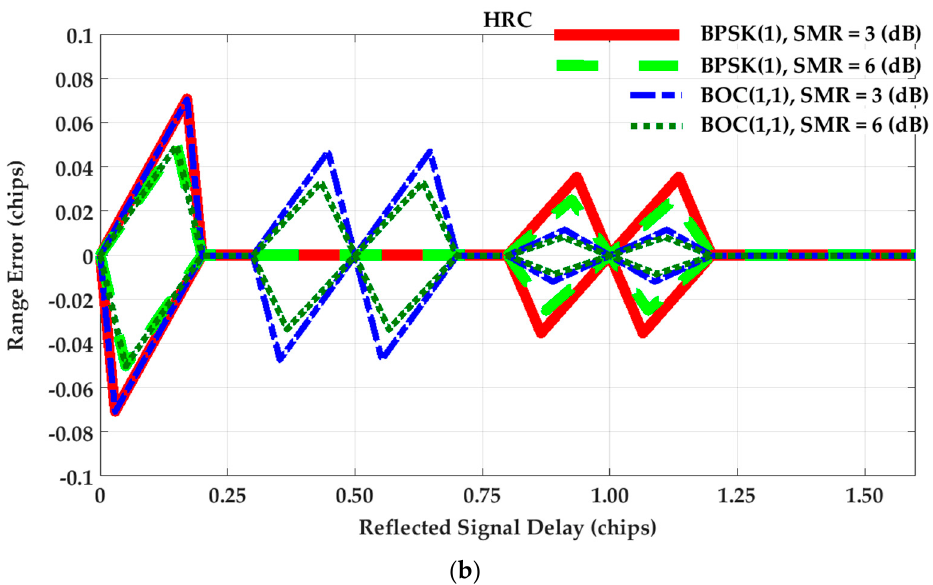
Figure 1. Multipath range error envelopes for ( a ) Narrow Correlator (NC) tracking strategy, BPSK(1) and BOC(1,1) signaling schemes; ( b ) High Resolution Correlator (HRC) tracking strategy, BPSK(1) and BOC(1,1) signaling schemes.